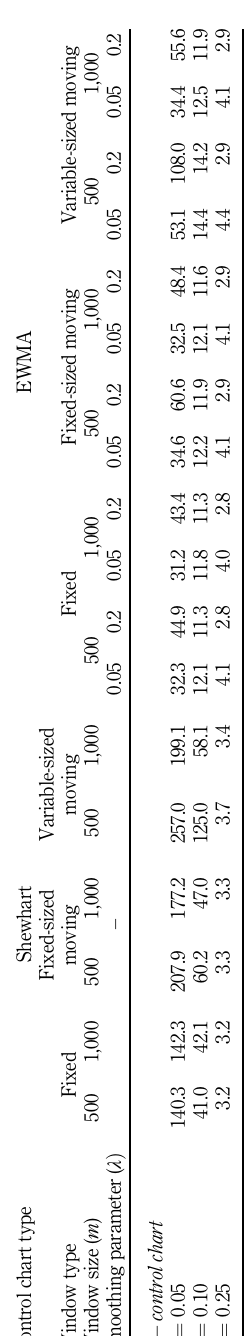
values for the Shewhart and EWMA control charts when m 5 500 and 1,000 networks assuming fixed, fixed-sized moving and variable- sized moving